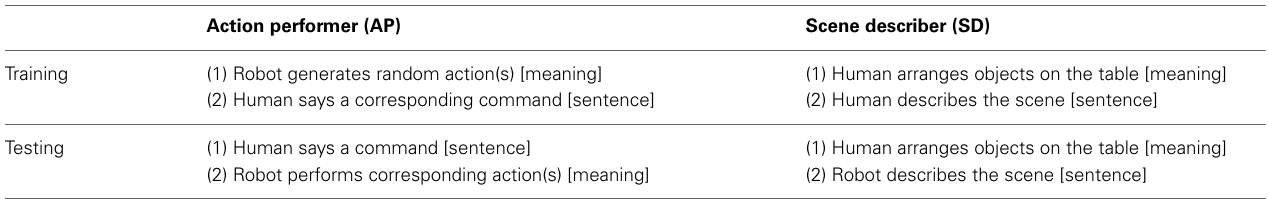
Table 2 | Summary of events in training and testing modes for the action Performer (AP) and scene describer (SD) tasks. Action performer